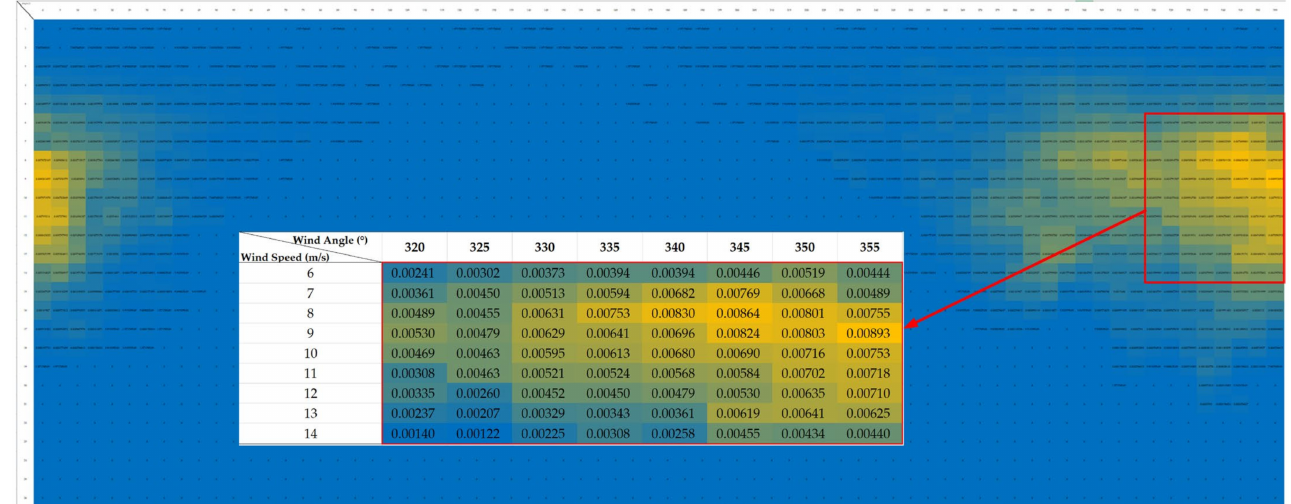
Figure 16. Wind field probability matrix under ballast condition on target route in January.